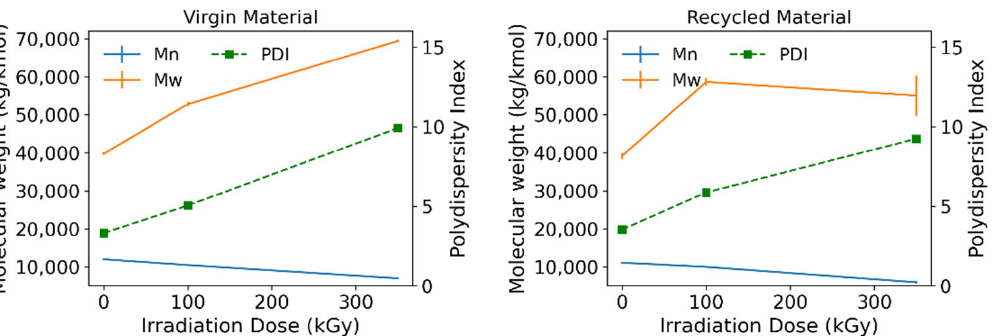
Figure 11. Weight and number average molecular weights for virgin (raw) and recycled material.